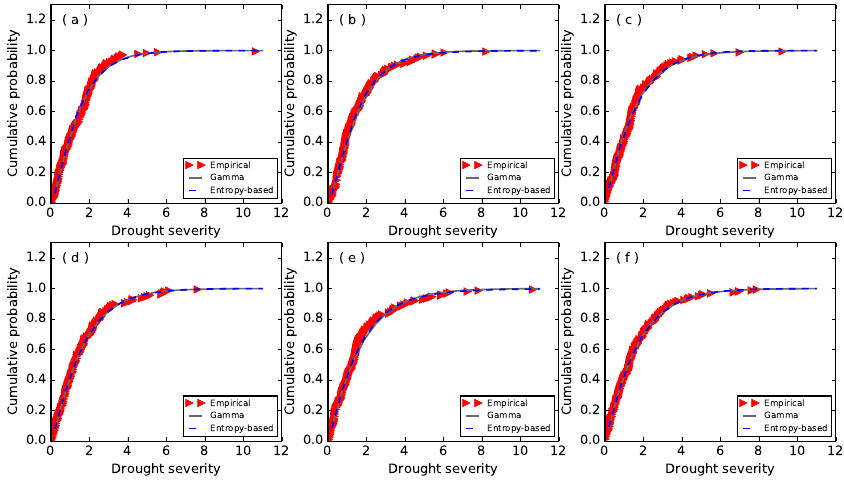
Figure 6. Cumulative distribution of drought severity at selected stations ( a – f ) as in Figure 5. Table 2. Passing rate in KS test ( α = 0.05) and mean RMSE and KS statistic D n .